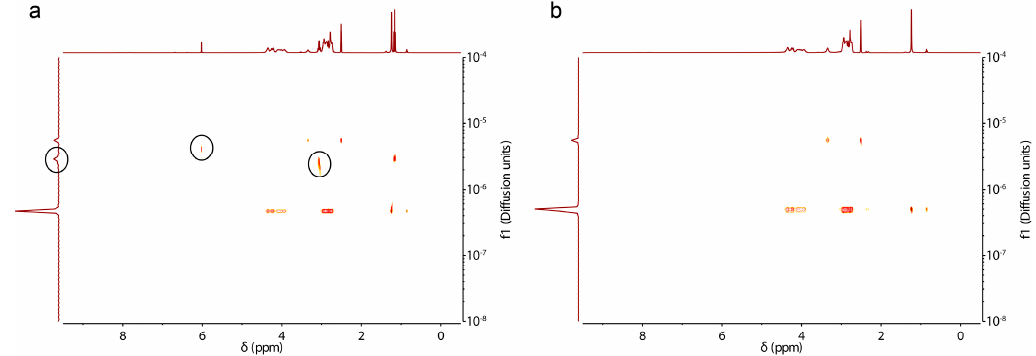
Figure A1. DOSY 1 H NMR of C 18 PSar 45 COOH ( a ) before, and ( b ) after removal of succinic anhydride.